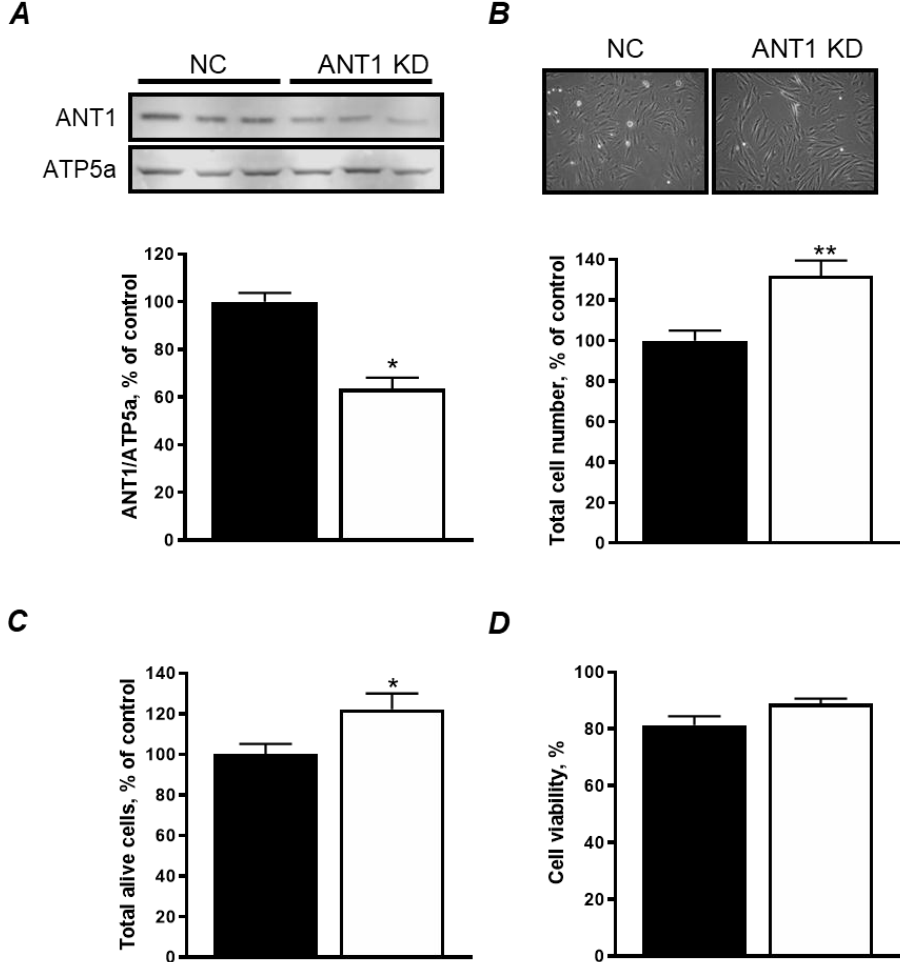
Figure 1. Cell viability is not affected by ANT KD in H9c2 cells. ( A ) Protein levels of ANT1 in negative control (NC) and ANT1 KD cells. Top panel: representative immunoblots. Bottom panel: quantitative data of ANT1 protein expression normalized to ATP5a (a mitochondrial housekeeping protein); ( B ) Total number of cells 48 h after transfection. Top panel: representative images of cells. Bottom panel: quantitative data of cells; ( C ) total number of live cells 48 h after transfection; ( D ) cell viability 48 h after transfection calculated as (alive cells / total cells) × 100. * P < 0.05 and ** P < 0.001 vs. NC. Data represent 4–7 independent experiments.